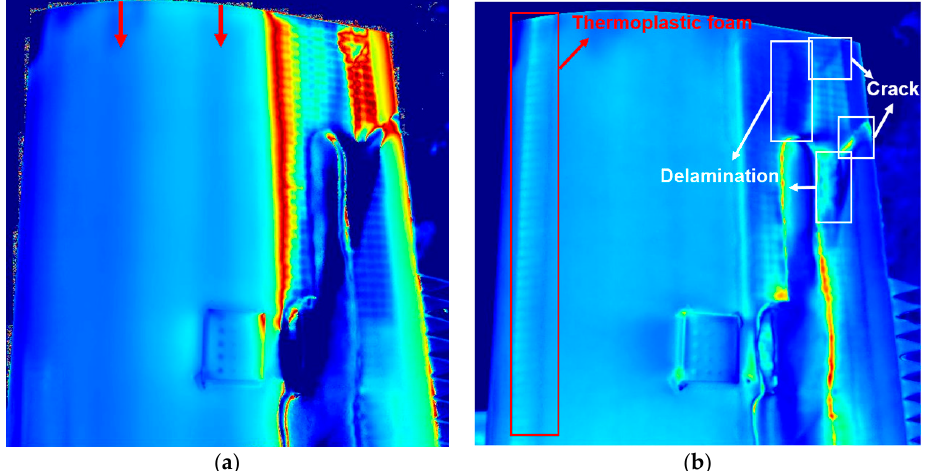
Figure 14. ( a ) Phase images of the passive thermograms captured during the morning at a frequency of 0.00184 Hz and ( b ) amplitude image of the passive thermograms recorded during the morning at a frequency of 0.0165 Hz.